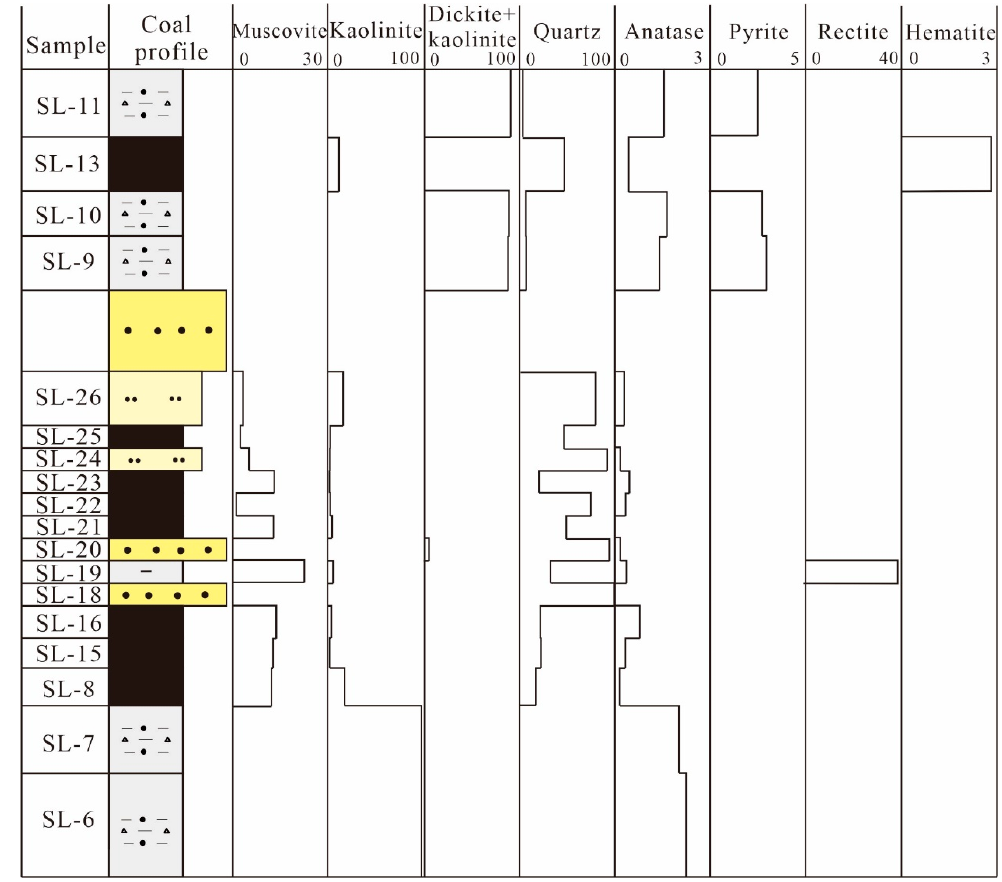
Figure 3. Vertical distribution of minerals throughout the outcrop profile.